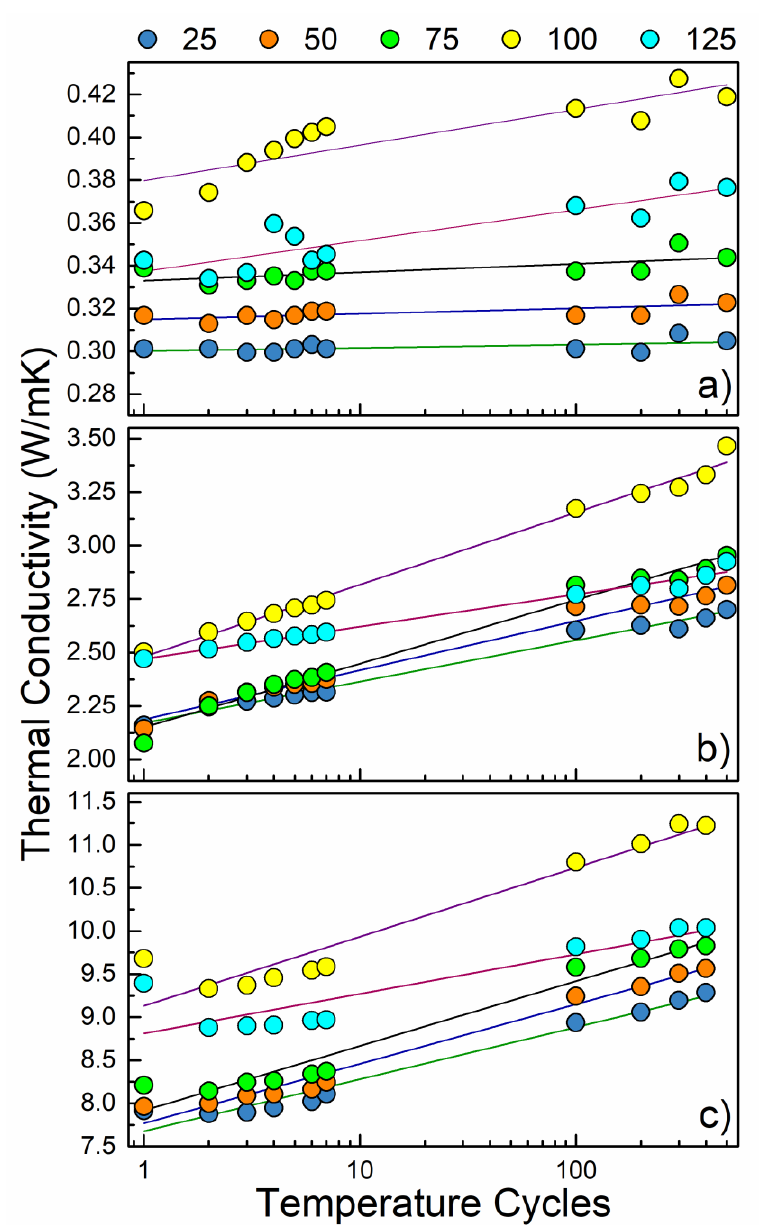
Figure 3. Thermal conductivity of ( a ) pure epoxy matrix, ( b ) TIMs with 5.4 vol% loading of graphene fillers, and ( c ) TIMs with 30 vol% loading of graphene fillers.